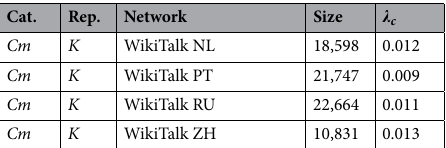
Table 1. The 60 case studies. We use the largest strongly connected component, whose size (node count) is reported here. Rep. denotes the source repository: K (KONECT 35,36 ), M (H. Makse 37 ), or S (SNAP 38 ). Cat. is the KONECT category most suited to the case study: Ca (Coauthorship), Cm (Communication between people), Cp (Computer), HS (Human Social, offline), In (Infrastructure), S (Social, online). (cid:31) c denotes the epidemic threshold, estimated